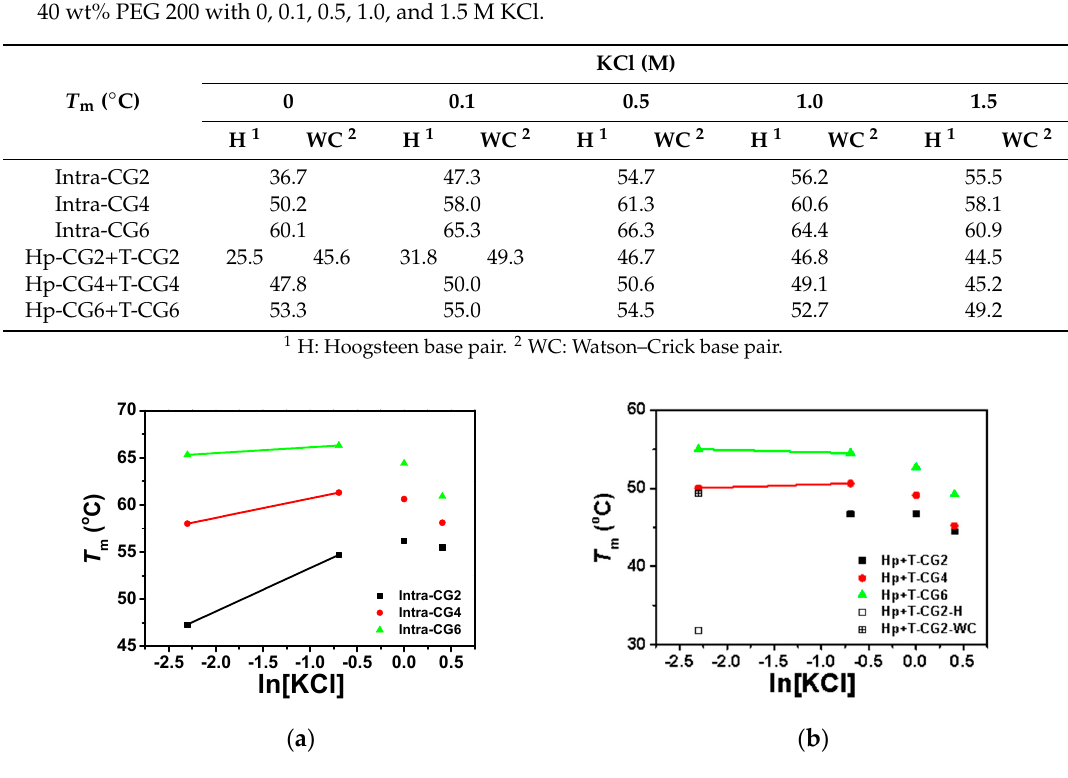
Figure 6. The plot of T m vs. ln[KCl] of ( a ) intramolecular triplexes and ( b ) intermolecular triplexes in the buffer containing 50 mM MES and 40 wt% PEG 200 at pH 6.0. T m of Hp-CG2+T-CG2 in 0.1 M KCl was separately plotted with Hoogsteen base pairs and Watson–Crick base pairs displayed with open square and + open square, respectively.